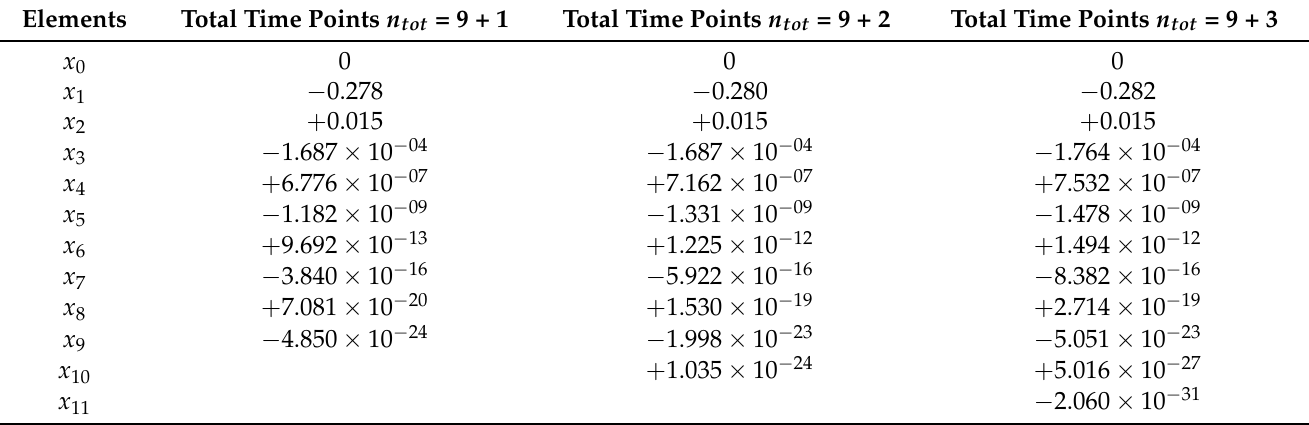
Table 2. The elements of the x vector, fully characterizing the interpolating Lagrange polynomials. The numeric values of the x vector elements for the functions g 10 ( t ) , g 11 ( t ) , g 12 ( t ) are shown in columns 1, 2, 3, respectively.